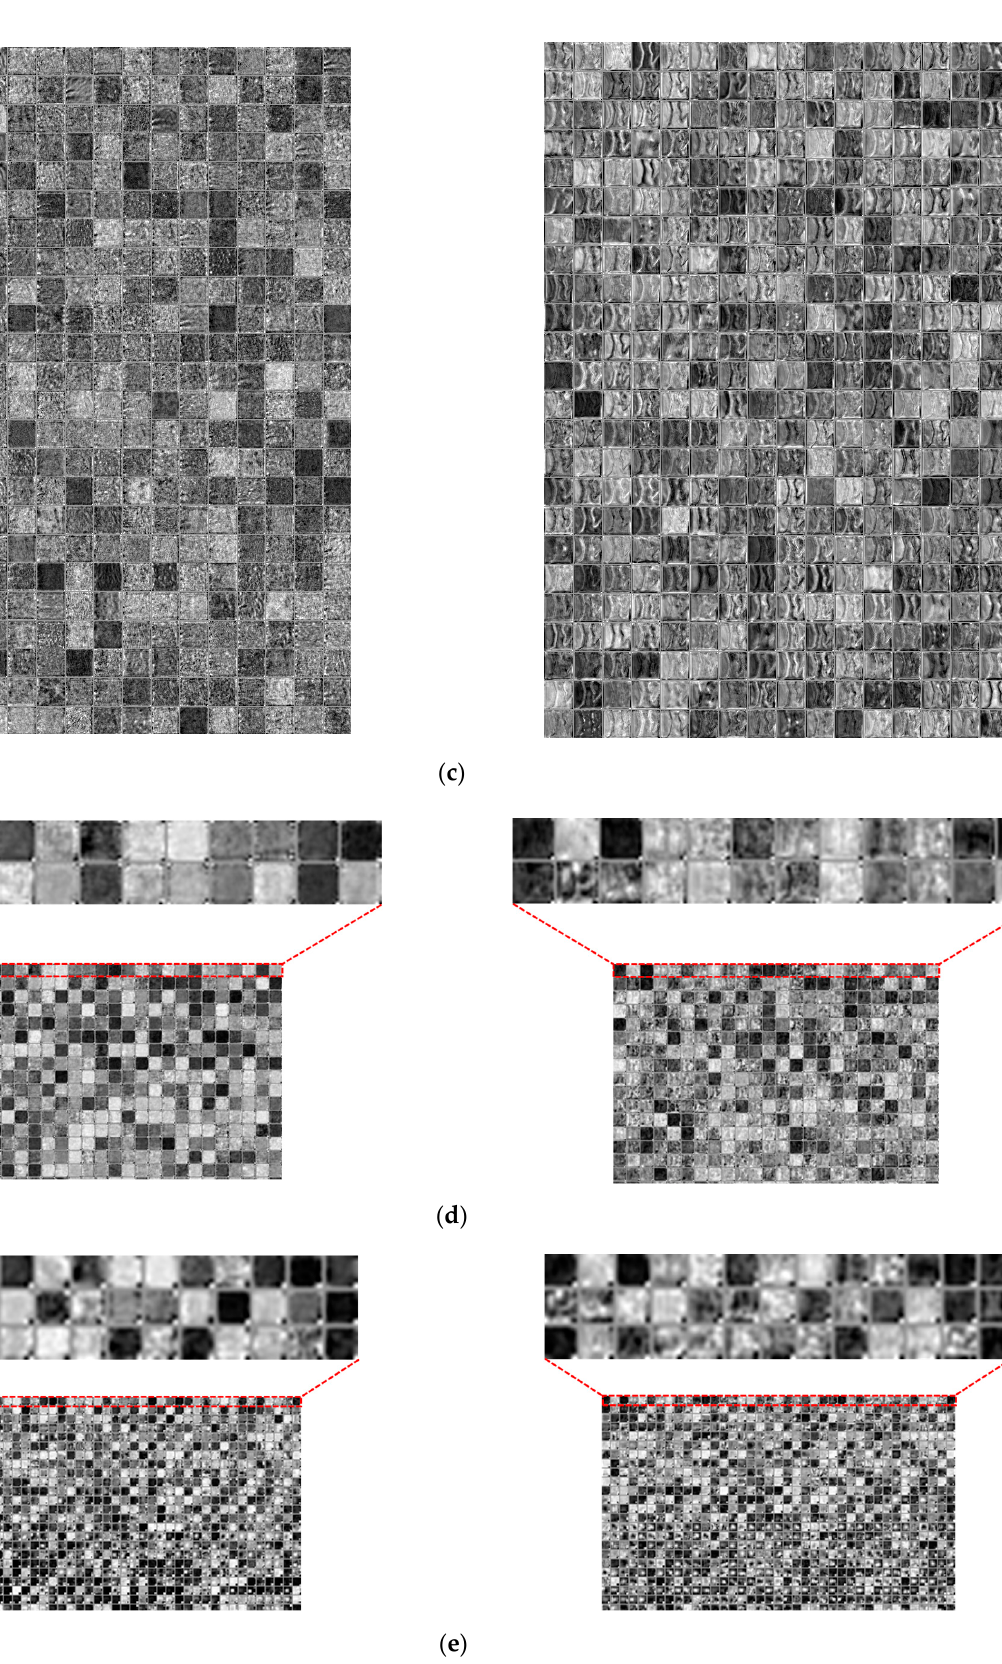
( f ) Figure 22. Feature maps extracted from a genuine matching image and an imposter matching image from several layers of the DenseNet-161. ( a ) Feature maps from the 1st convolutional layer; ( b ) feature maps from the 1st transition layer; ( c ) feature maps from the 2nd transition layer; ( d ) feature maps from the 3rd transition layer; ( e ) feature maps from the last dense block, and ( f ) 3D feature maps created by averaging feature map values of ( e ). Upper and lower examples in ( a – f ) represent genuine matching feature maps and imposter matching feature maps, respectively. As shown in Figure 22, abstract features were extracted as the layer became deeper. For example, low-level features, such as lines and corners of the original image, were maintained in Figure 22a, whereas, in Figure 22e, only the abstracted features remained, and shape information mostly disappeared. As shown in Figure 22a–e, the feature maps of authentic and imposter matching do not seem to have a significant difference. How- ever, as shown in Figure 22f, although the changes in the 3-dimensional feature map val- ues drawn by calculating the average of feature map values for the authentic matching results from a step before the classification layer were mostly flat, the results of imposter matching showed that the changes in the feature-map values were greater than those of authentic matching. Therefore, the difference in the CNN feature maps of authentic and imposter matching by the proposed method was confirmed. 5. Conclusions In this study, a motion blurred finger-vein image was restored to solve the problem of deterioration of finger-vein recognition performance due to motion blur, and a recog- nition method using deep CNN was studied to evaluate the performance of the restored image. A modified DeblurGAN was proposed by modifying the original DeblurGAN, which was a restoration model. Using two open databases, the recognition error rate was lower when recognition was performed using the restoration method proposed in this study than when images were not restored. Furthermore, based on the comparative ex- periments using various state-of-the-art restoration models, the proposed method was more effective in restoring an image from motion blur and had more improved recogni- tion performance. Also, based on the analysis of class activation maps and feature maps,